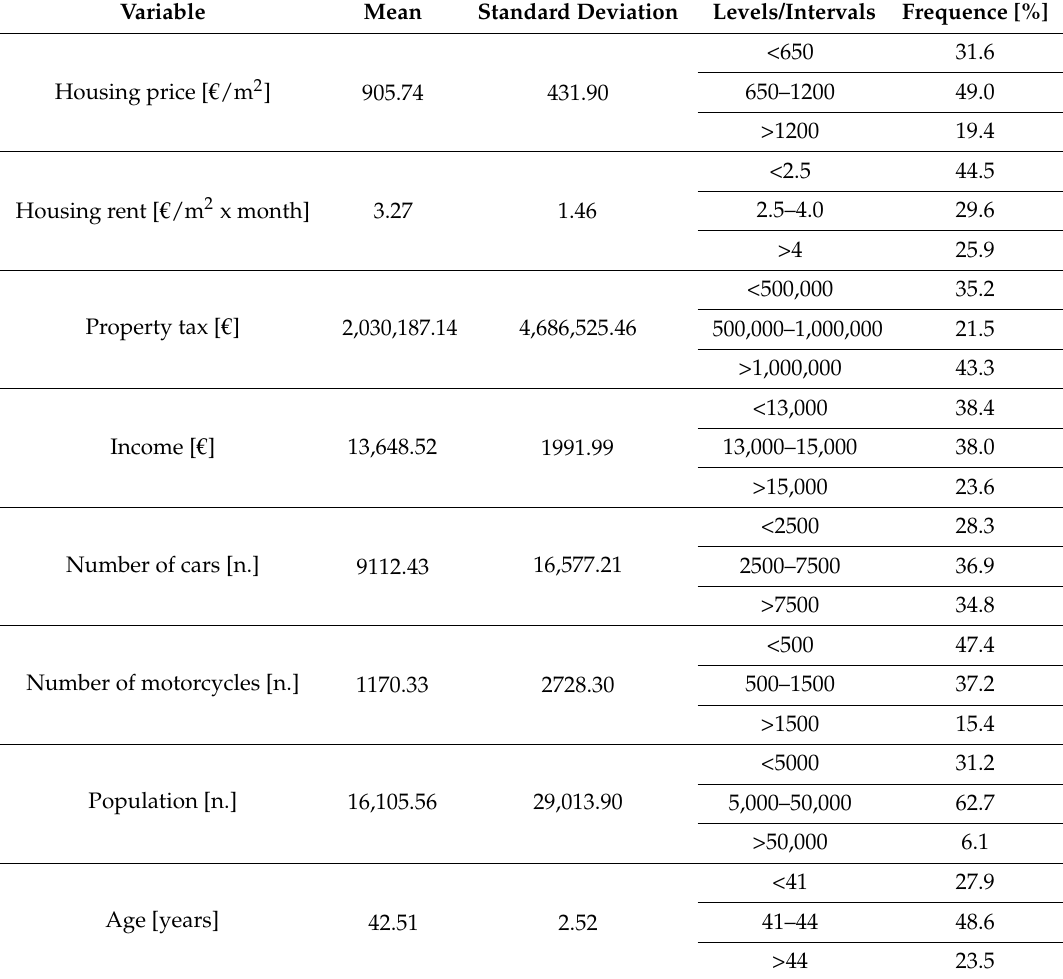
Table 1. Descriptive statistics of the variables of the sample in the year 2011. Variable Mean Standard Deviation